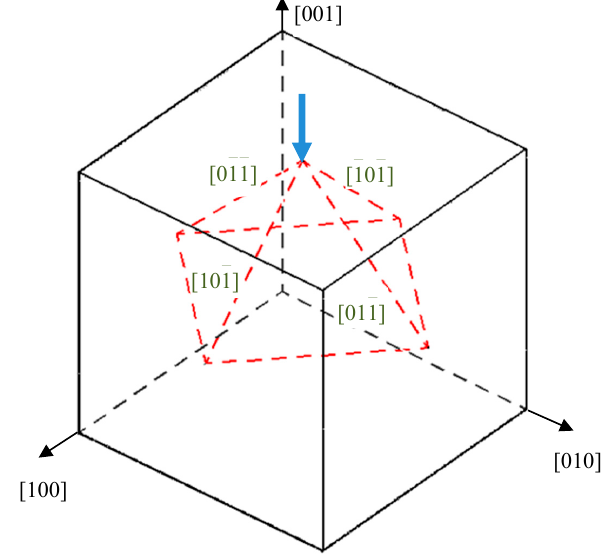
(cid:2) (cid:3) 001 .